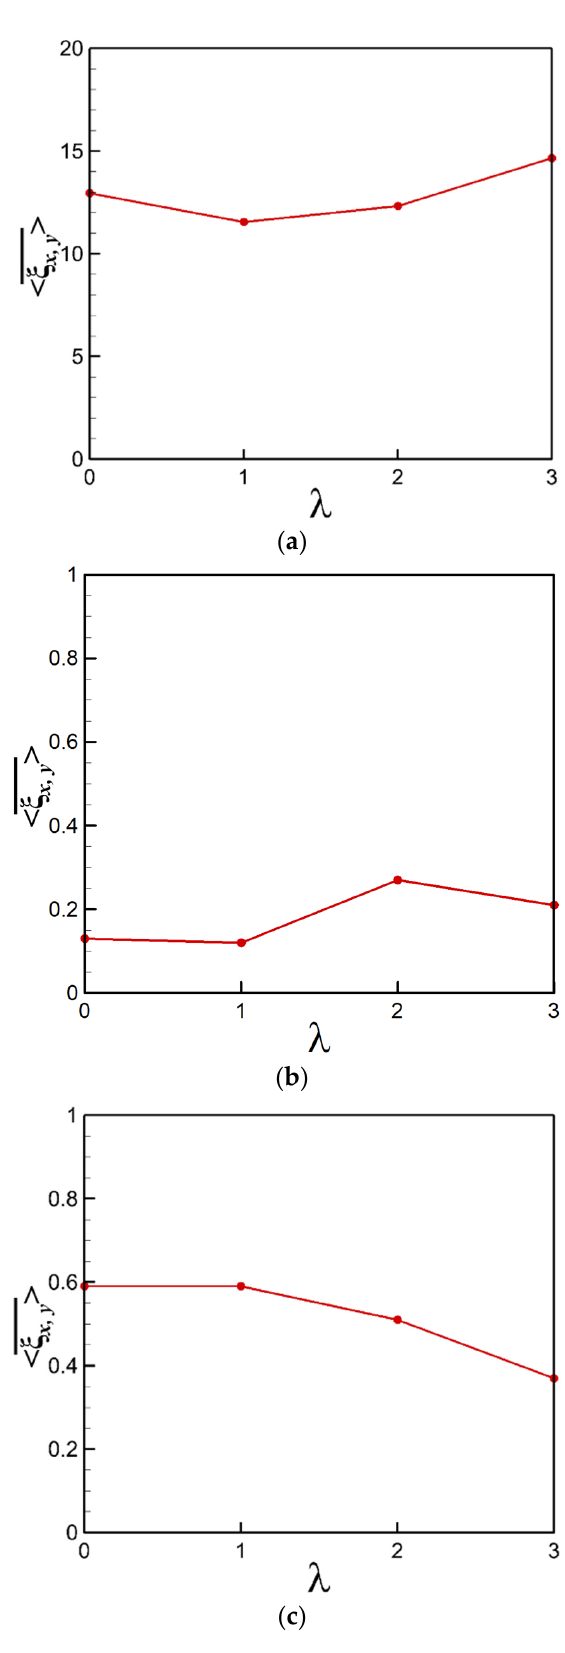
Figure 7. Distribution of the volume-averaged orthogonal enstrophy as a function of the wavelength. ( a ) Re = 100; ( b ) Re = 500; ( c ) Re = 1000.